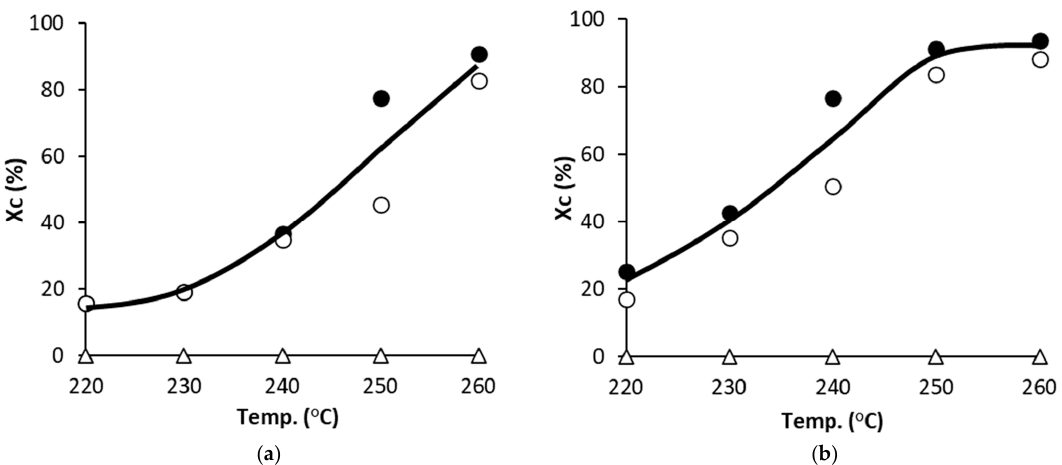
Figure 2. ( a ) Cellulose conversion (X c ) to products with reaction temperature. Two indepen- dent experiments under N 2, shown (( • ), ( )), are for a starting cellulose concentration of 40 g.L − 1 ; (cid:35) ( – ) represents average X c under N 2 ; ( (cid:52) ) is the control experiment with no heat. ( b ) Cellulose conversion (X c ) to products with reaction temperature under CO 2 ; ( • ), ( ) denote two independent experiments (cid:35) under CO 2 ; ( – ) represents average X c under CO 2 . Reaction pressure was from 60 to 90 bars. Cellulose conversion to products is the average of two experiments with variation between replicates within ±